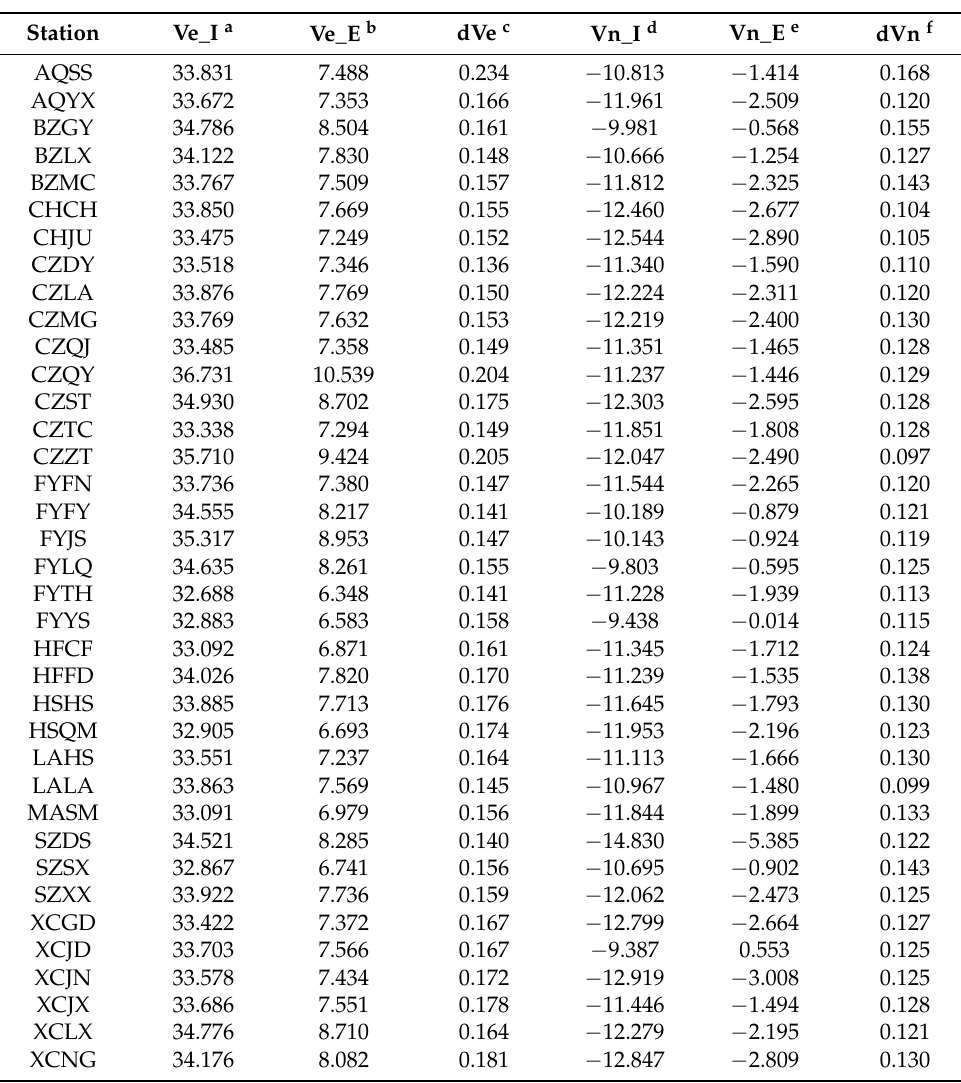
Table 2. Site velocity